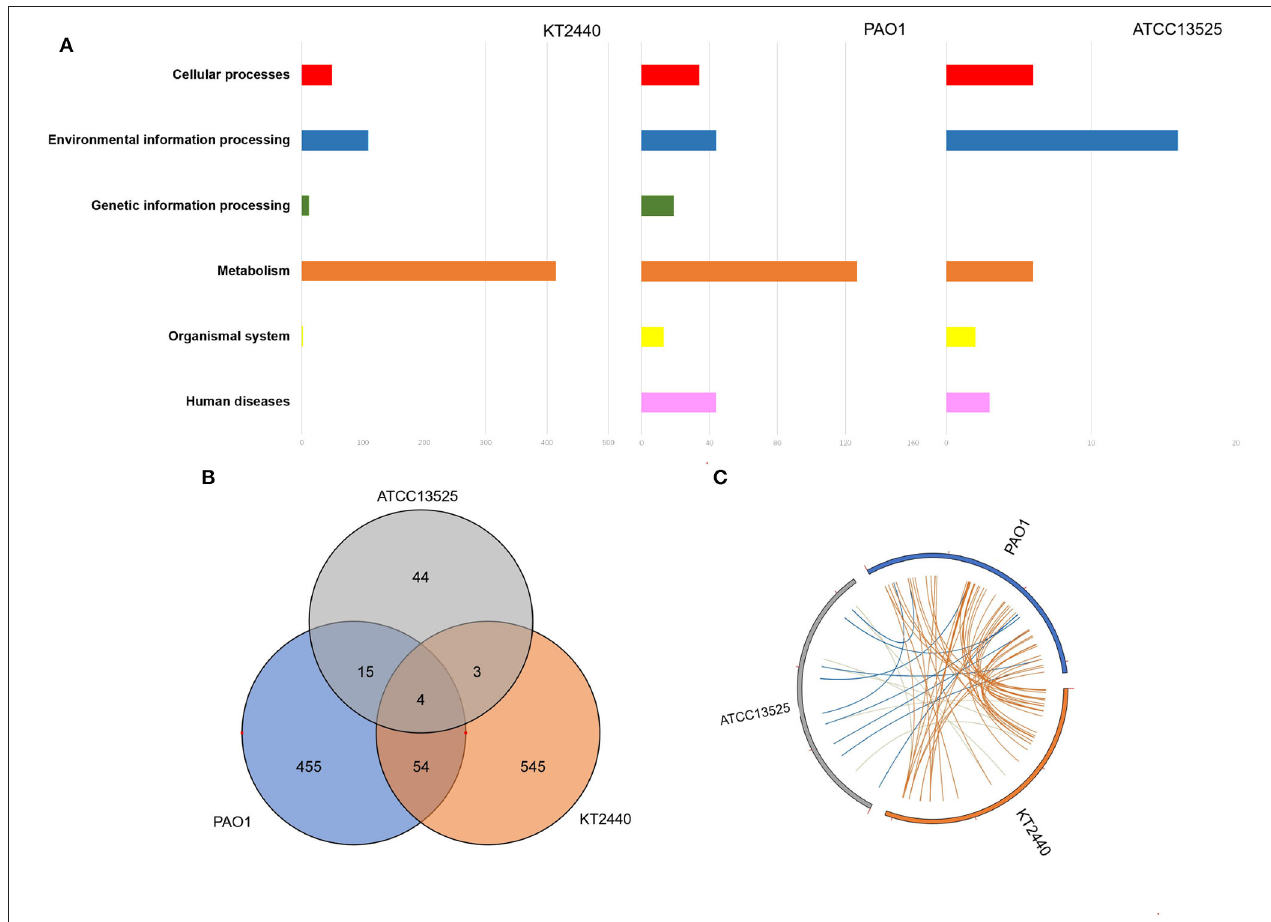
FIGURE 1 | Global transcription features of three Pseudomonas strains. (A) KEGG analysis of DEGs identified in P. aeruginosa PAO1, P. putida KT2440, and P. fluorescence ATCC 13525 T . (B) Venn diagram showing the DEGs commonly or strain-specifically regulated by these three Pseudomonas strains. (C) Genome location of these genes regulated by more than one